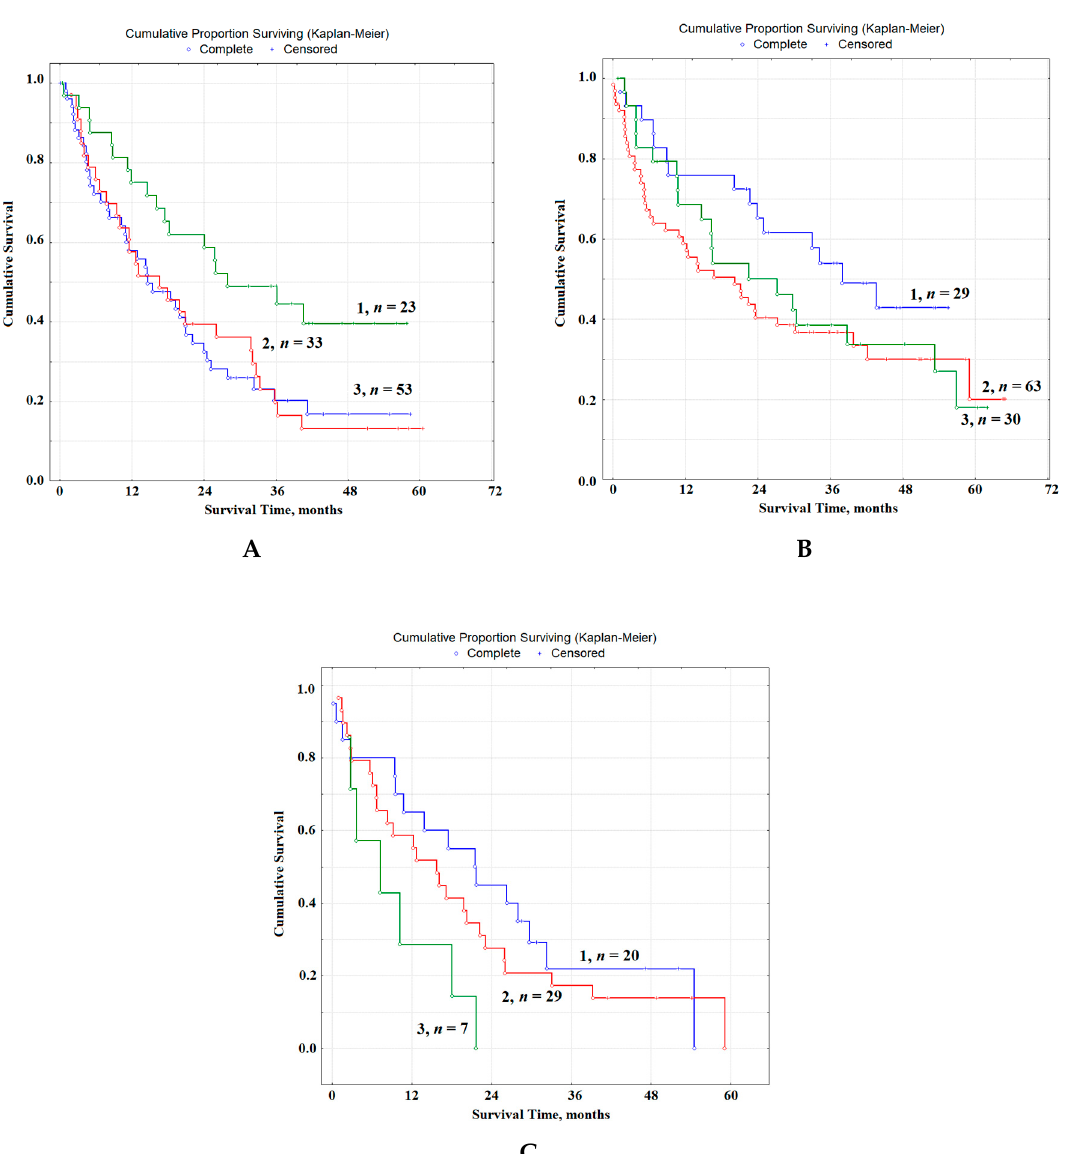
Figure 5. Multivariate regression analysis of overall survival: ( A ) ICs < 0.478 mmol / L and Figure 5 LDH > 1248 U / L (curve 1, favorable prognosis, median 26.3 months), ICs > 0.478 mmol / L and LDH < 1248 U / L (curve 2, poor prognosis, median 16.9 months), other combinations (curve 3, median 14.5 months); ( B ) ICs < 0.182 mmol / L (curve 1, median 34.5 months), 0.182 < ICs < 0.455 mmol / L (curve 2, median 14.3 months), ICs > 0.455 mmol / L (curve 3, median 16.7 months); ( C ) pH < 6.74 and LDH < 1006 U / L (curve 1, favorable prognosis, median 21.9 months), pH > 6.74 and LDH > 1006 U / L (curve 3, poor prognosis, median 7.3 months), other combinations (curve 2, median 16.0 months). n is the number of patients in each